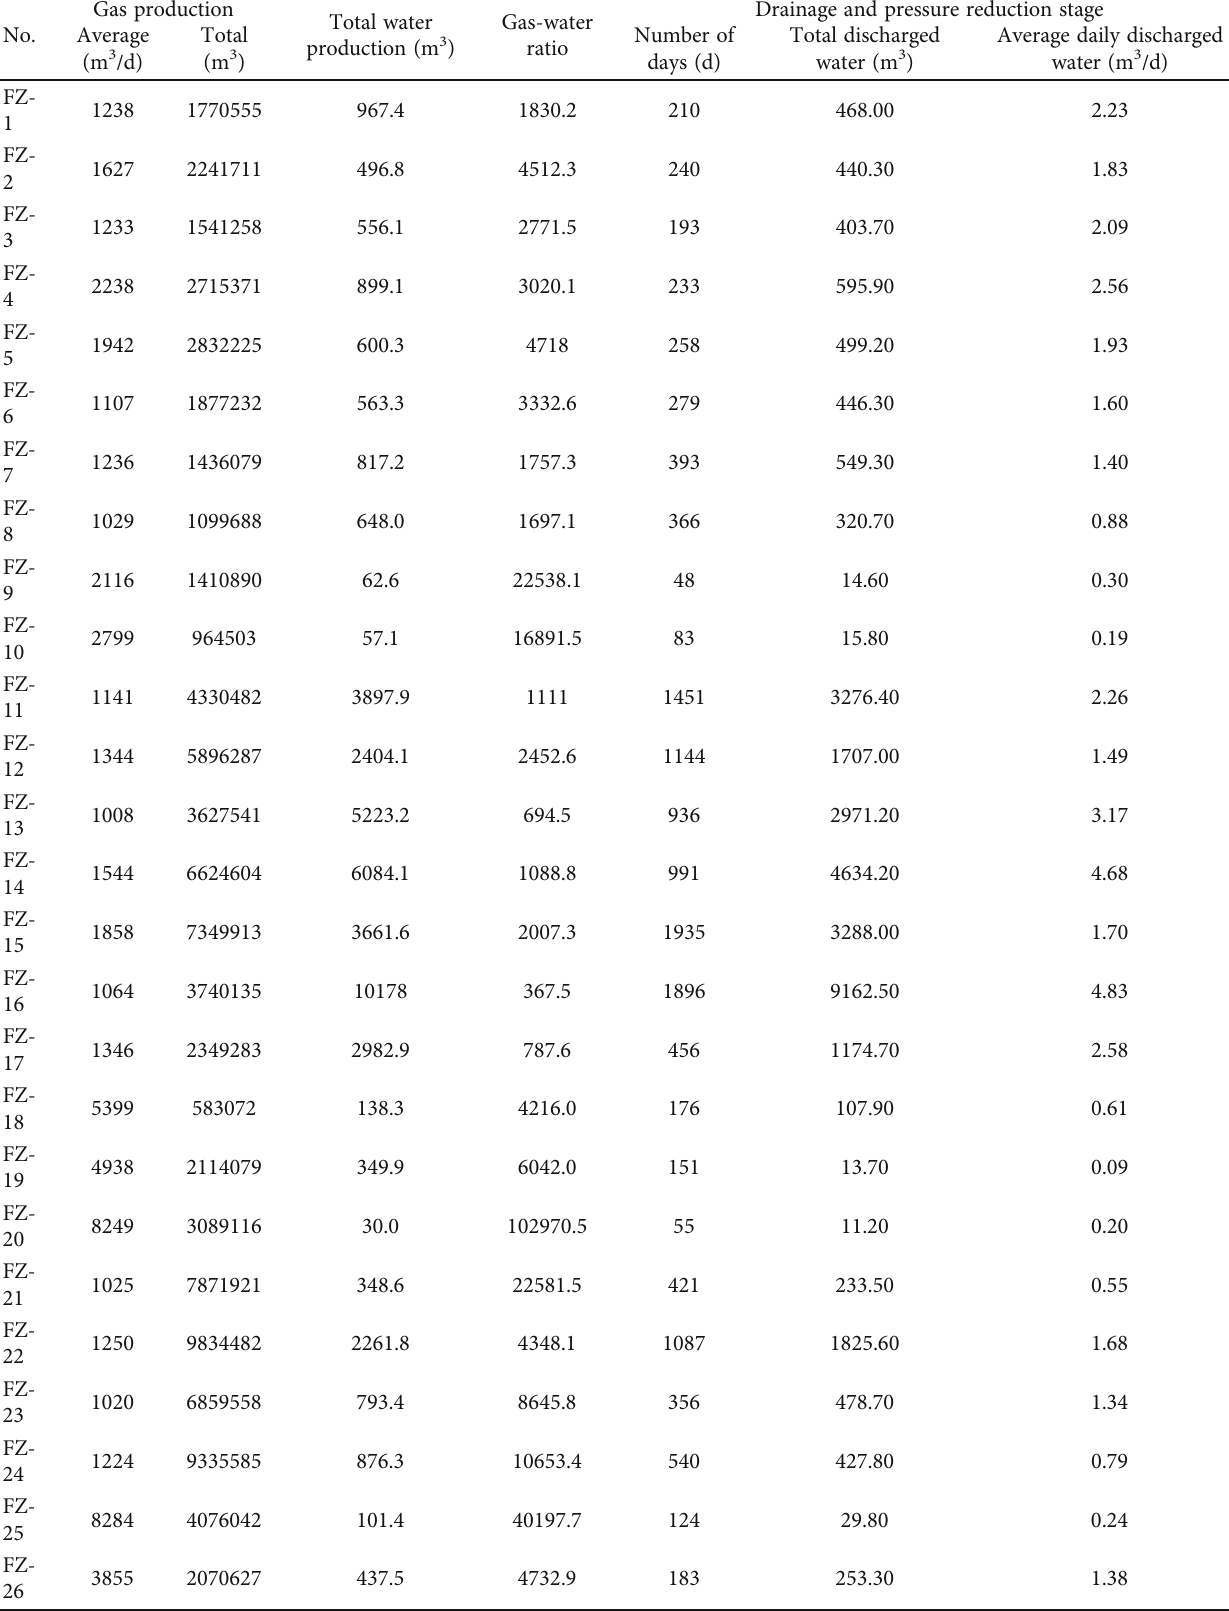
Table 3: CBM well gas and water productivity in the Fanzhuang